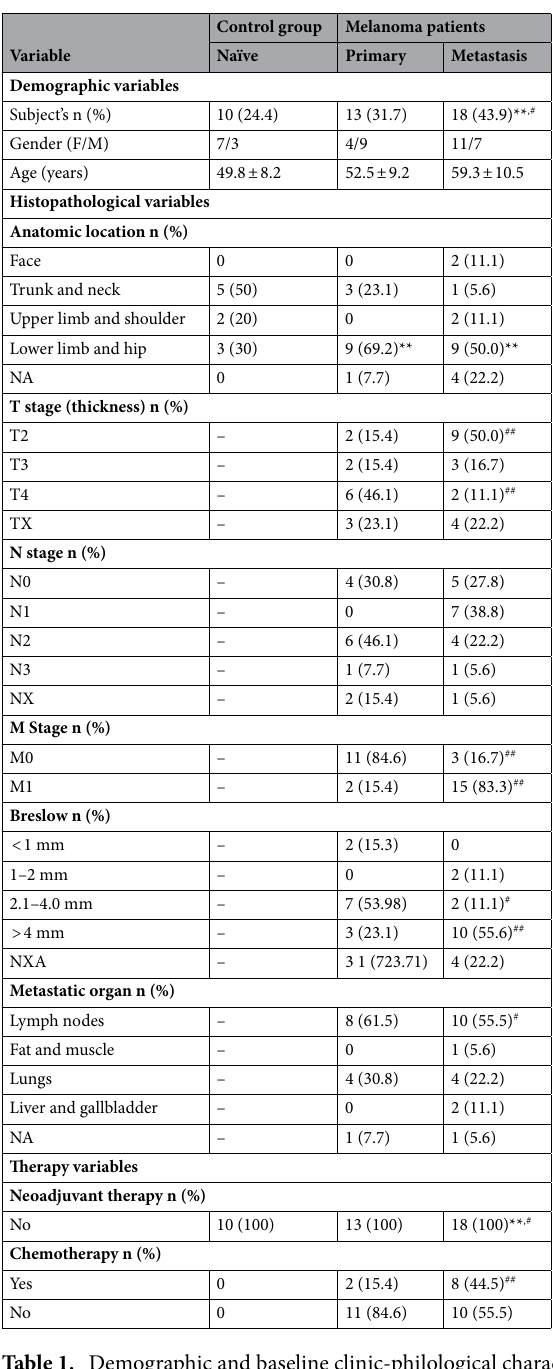
Table 1. Demographic and baseline clinic-philological characteristics. Data are presented as mean ± SD for all others. Naïve, healthy subjects with normal skin. Patients were categorized according to the World Health Organization (WHO) guidelines and the pTNM Union for International Cancer Control (UICC) pathological staging criteria. NA not available, NX not determined. * p < 0.05 and ** p < 0.001 vs the naïve group; # p < 0.05 and ## p < 0.001 vs the primary